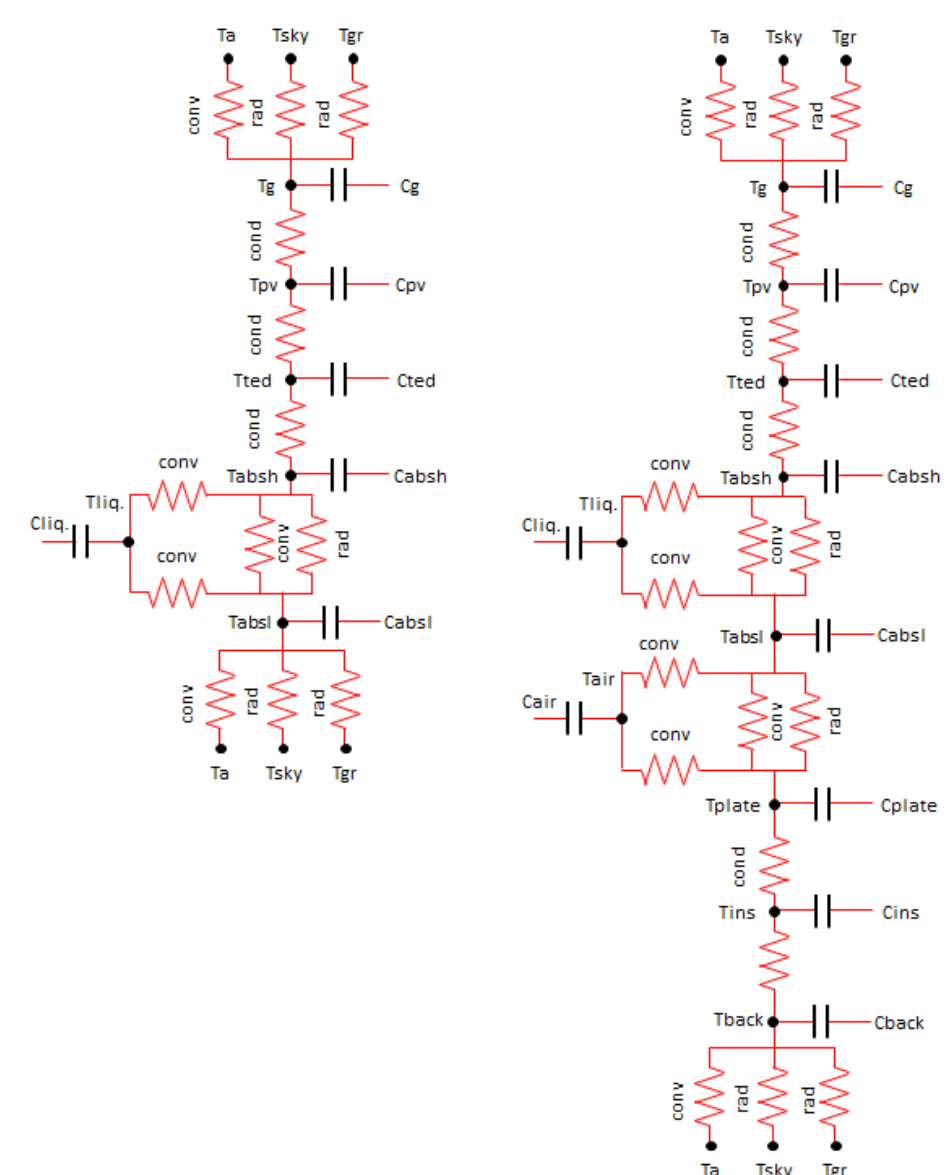
Figure 2. Equivalent electrical circuits for the reference PV/T ( left ) and PV/Tb collectors ( right ). The radiative exchanges have been calculated using the Stefan–Boltzmann law (Equation The heat fluxes among the collector’s layers and with the outdoor environment are governed by the three heat transfer mechanisms: radiation, convection, and conduction.